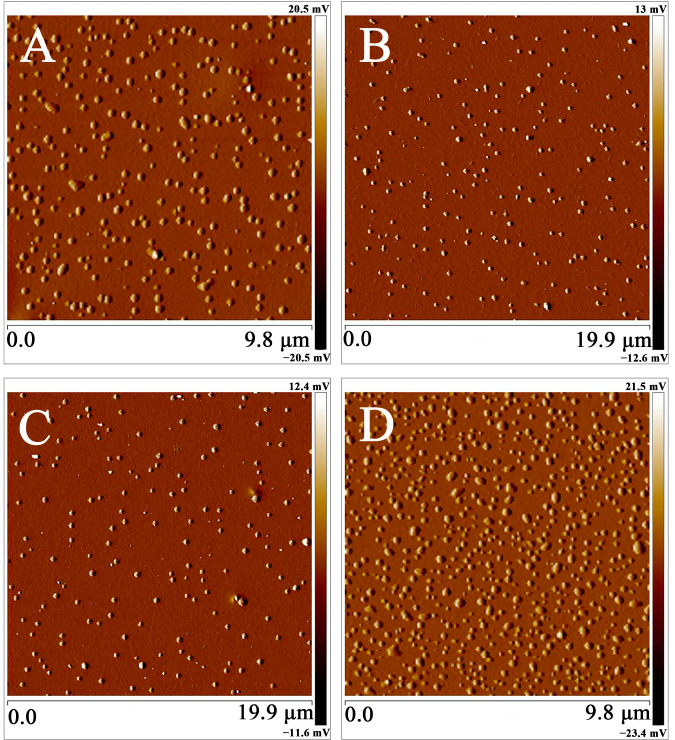
Figure 8. AFM images of PBLG-g-GdPO 4 ·H 2 O/PLGA with grafting rates of 4.14% ( A ), 5.93% ( B ), 13.72% ( C ) and 15.93% ( D ).